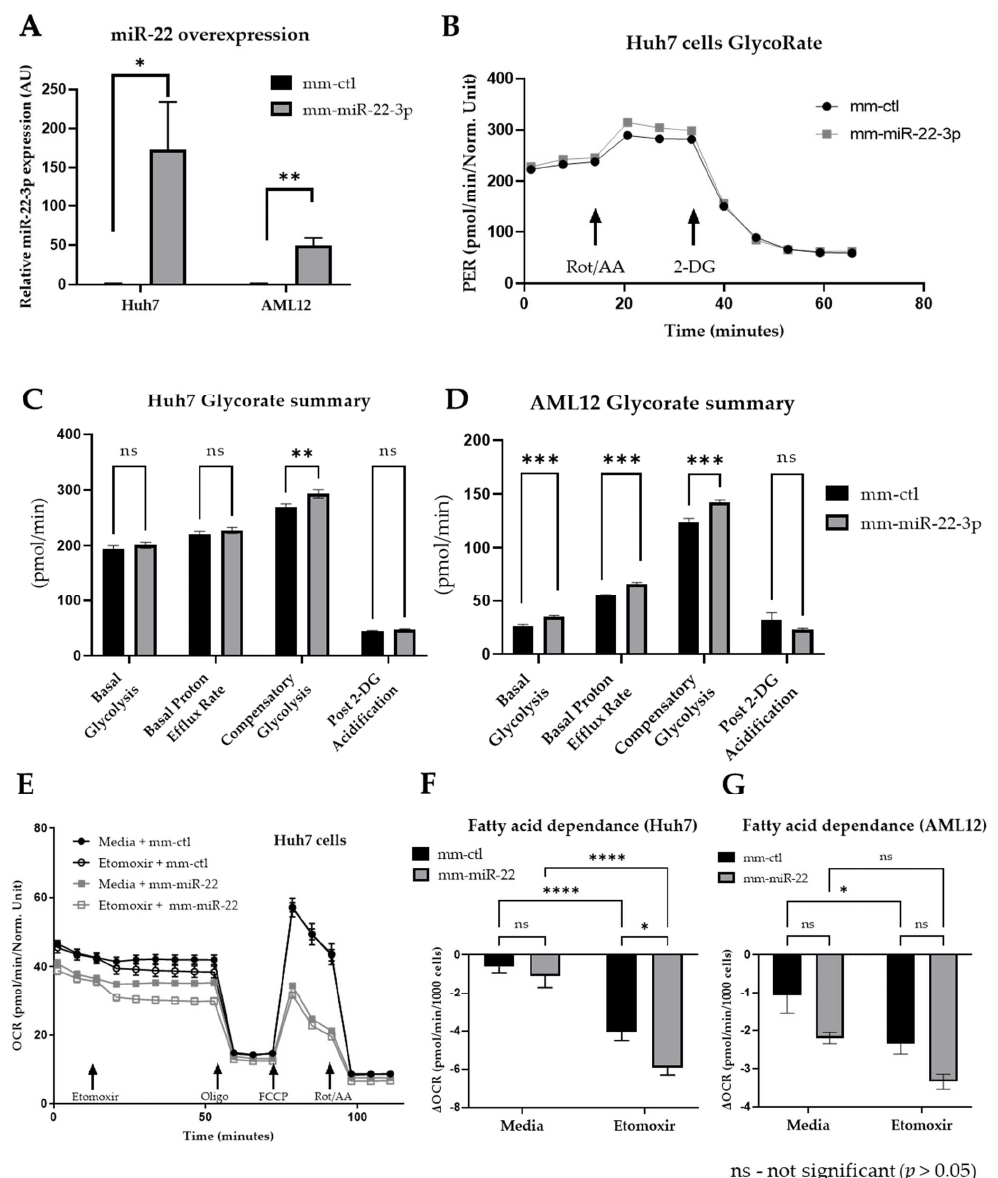
Figure 5. Glycolysis rate and fatty acid-dependence of miR-22-overexpressing hepatic cells. ( A ) RT- qPCR analysis of miR-22-3p expression in Huh7 and AML12 cells transfected with 20 nM of miR- 22-3p-mimicking oligonucleotides (mm-miR-22-3p) or control oligonucleotides (mm-ctl), 48 h post- transfection. ( B ) Representative traces of glycolysis rate measurement (GlycoRate, Seahorse Agilent technology) in Huh7 cells transfected or not with miR-22-3p-mimicking oligonucleotides for 48 h. GlycoRate quantification in ( C ) Huh7 and ( D ) AML12 cells transfected with 20 nM of mm-miR-22-3p or mm-ctl, 48 h post-transfection. ( E ) Representative traces of long-chain fatty acid oxidation level determined by measuring the oxygen consumption rate (OCR) measurement (Seahorse Agilent technology) in the presence/absence of Etomoxir (inhibitor of fatty acid transport to mitochondria) in Huh7 cells overexpressing miR-22-3p or not, 48 h post-transfection. Fatty acid dependence (acute response to Etomoxir) in ( F ) Huh7 and ( G ) AML12 cells from the previous panel. Data are represented as mean +/ − SEM. Statistical relevance of ( A , C , D ) was analyzed with Student’s t -tests and two-way ANOVA (multiple comparisons) was used in ( F , G ). p -values are represented as follows: * p ≤ 0.05; ** p ≤ 0.01; *** p ≤ 0.001; **** p ≤